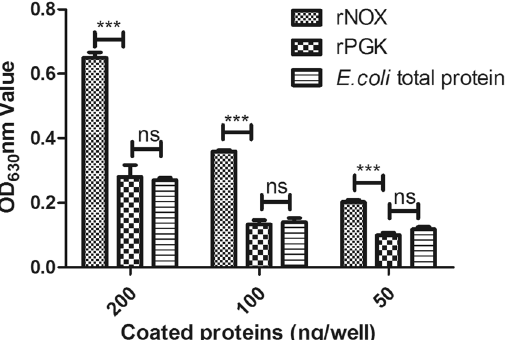
Figure 6. The fibronectin-binding ability of rNOX. The rNOX, rPGK, and E. coli total protein were applied to examine the fibronectin activity with indirect ELISA. Different amounts of proteins were coated in the 96 wells of ELISA plate. After washing and blocked with 5% BSA, 200 ng fibronectin in 100 μ l PBST was added into each well and incubated for 1 h. And then the anti-fibronectin mAb and goat anti-mouse antibodies were sequentially overlaid to detect the binding activity. *** Represents very significant difference ( p < 0.001), while “ns” represents no